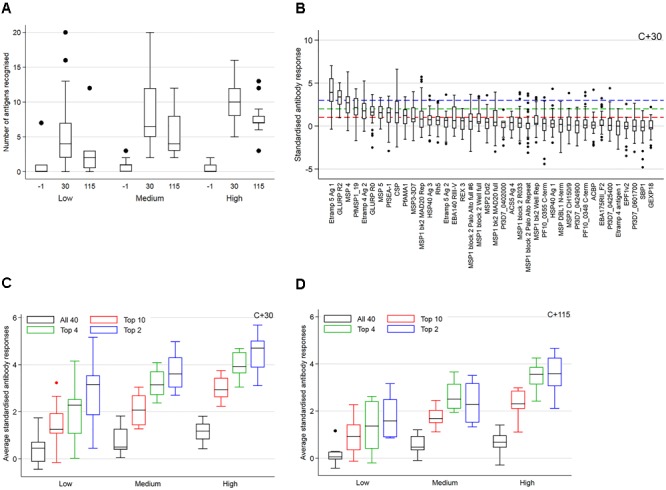
The number of antigenic targets recognized at three time points (A), standardized antibody responses (B) and averaged standardized antibody responses (C,D). In (A,C,D) results are shown over tertiles of cumulative parasite density (expressed as the log-transformed area under the curve for parasite density versus time until, and including the day of treatment). In (A) results are further categorized over time points post-challenge. An antigen is considered recognized if antibody responses (expressed as log-transformed median fluorescence intensity corrected for background reactivity) were higher than the mean plus two standard deviations (SD) of pre-challenge responses across 45 participants (i.e., seropositive). In (B–D) antibody responses were standardized by subtracting the mean of pre-challenge responses across 45 participants and dividing by its SD. In (B) standardized antibody responses 30 days post-challenge are ordered by median reactivity on the x-axis. Dashed lines represent arbitrary thresholds at 1 SD (red – top 10 antigenic targets), 2 SD (green – top 4 antigenic targets) or 3 SD (blue – top 2 antigenic targets) greater than the mean of pre-challenge responses. In (C,D) standardized antibody responses to antigens with a median above these arbitrary thresholds were averaged and are shown 30 days (C) and 115 days (D) after challenge, using the same color scheme. Average responses across all 40 targets are shown in black.